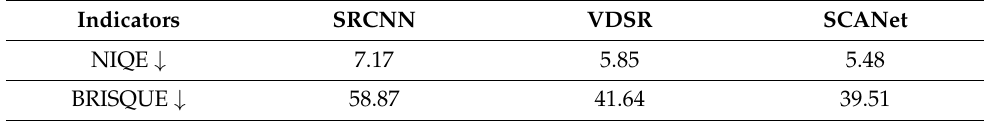
Table 3. Subjective quality comparisons with different no-reference image quality